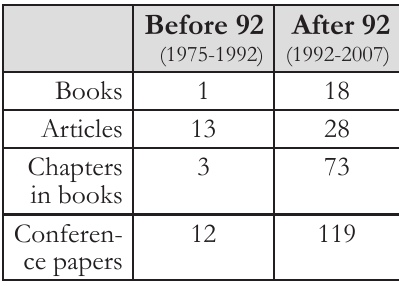
Table 1: The Aalborg